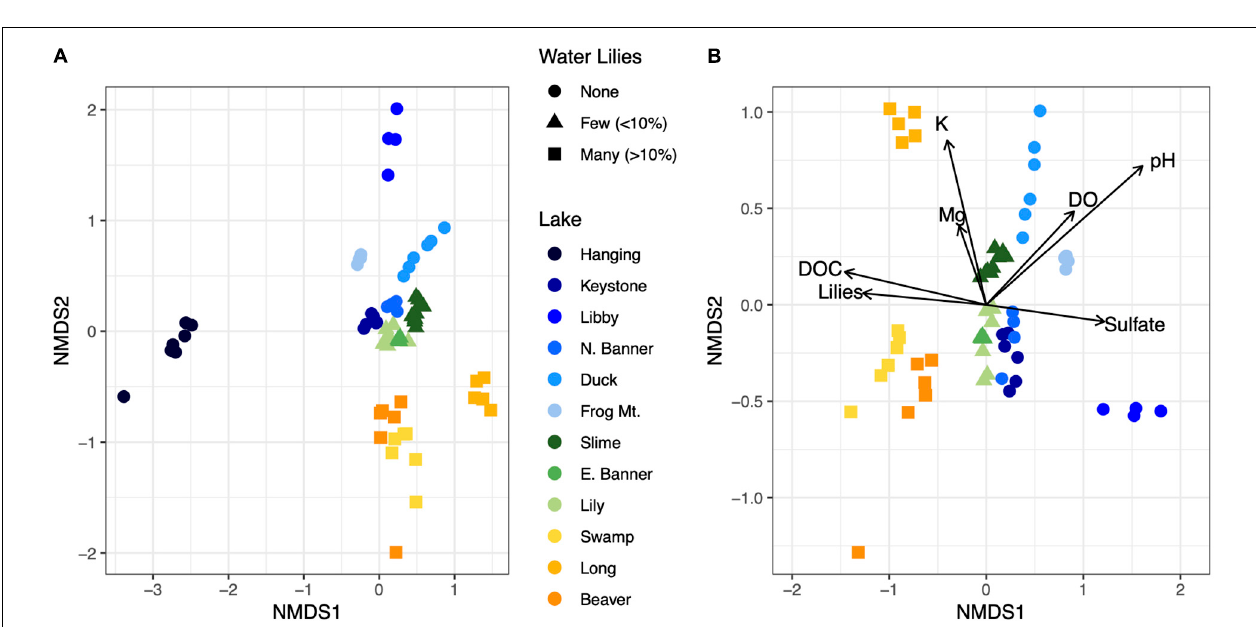
FIGURE 2 | Point estimates for microbial richness estimated with Breakaway (A) and Shannon Diversity (B) for water samples from all 12 lakes.